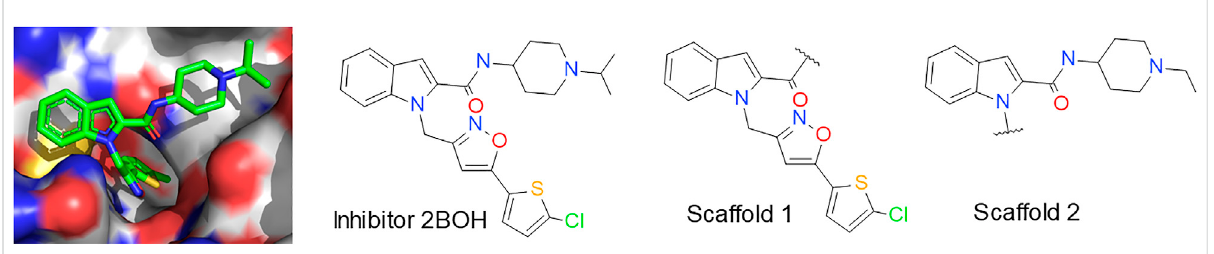
FIGURE 2 Inhibitor from PDB entry 2BOH (Nazaré et al., 2005a). The left image shows the 3D structure of the inhibitor in the pocket illustrated in PyMol (The PyMOL, 2022), on the right the two scaffolds used for Lib-INVENT are displayed. The atoms in the surface are colored by their element